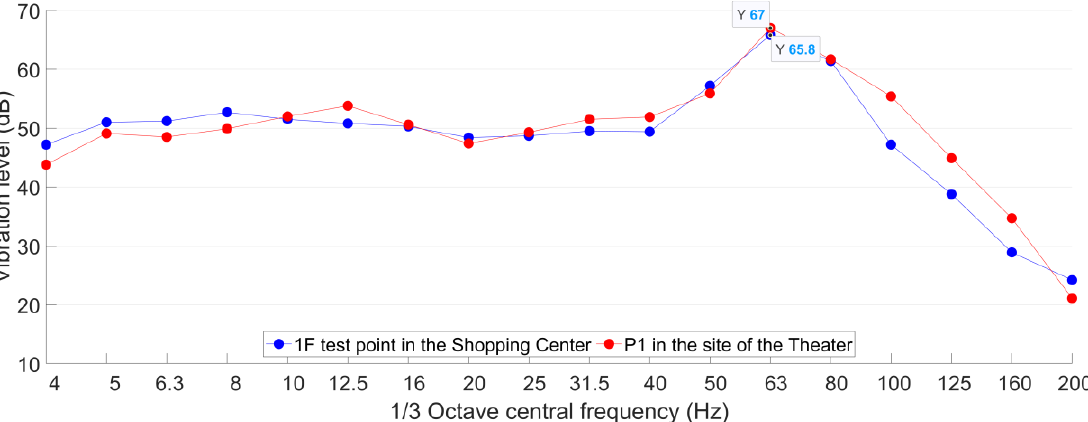
Figure 14. Typical acceleration responses in time ( a ) and frequency ( b ) domain in P1 in the site of the theater.